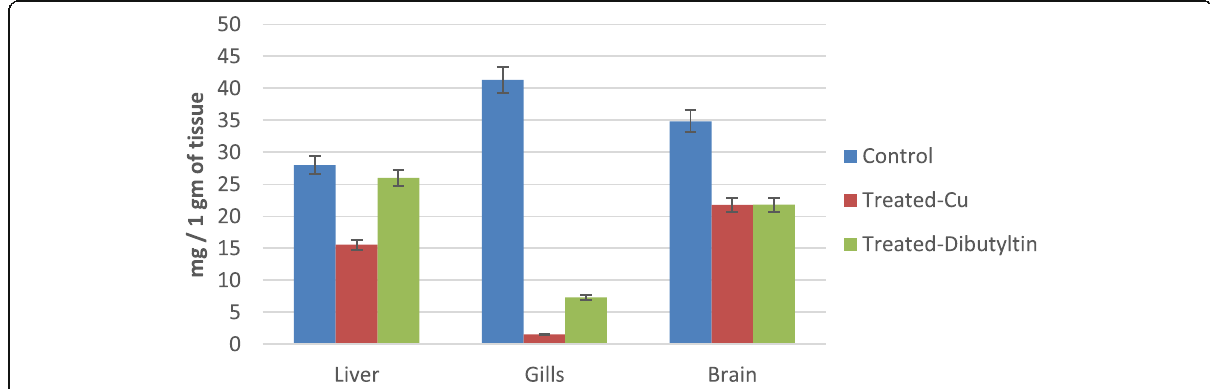
Fig. 8 Average protein content in tilapia in the liver and gills in Control, Cu-treated, and dibutyltin-treated. Data were expressed as mean and error bars indicate